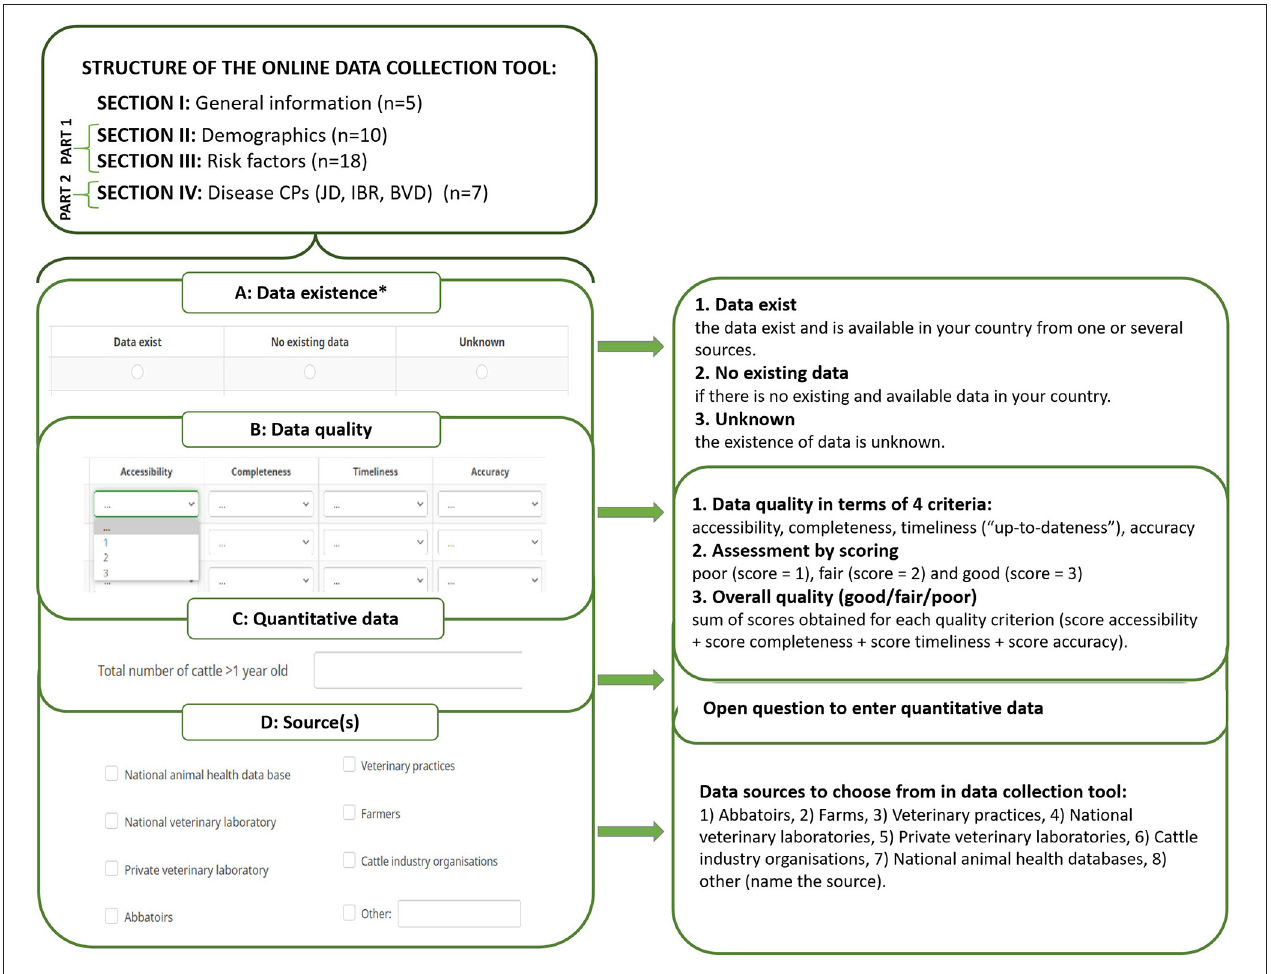
FIGURE 1 | The structure of the online data collection tool that was used to overview data related to control programs of infectious cattle diseases among 32 SOUND control COST Action member countries. *, mandatory part; n , number of variables per section